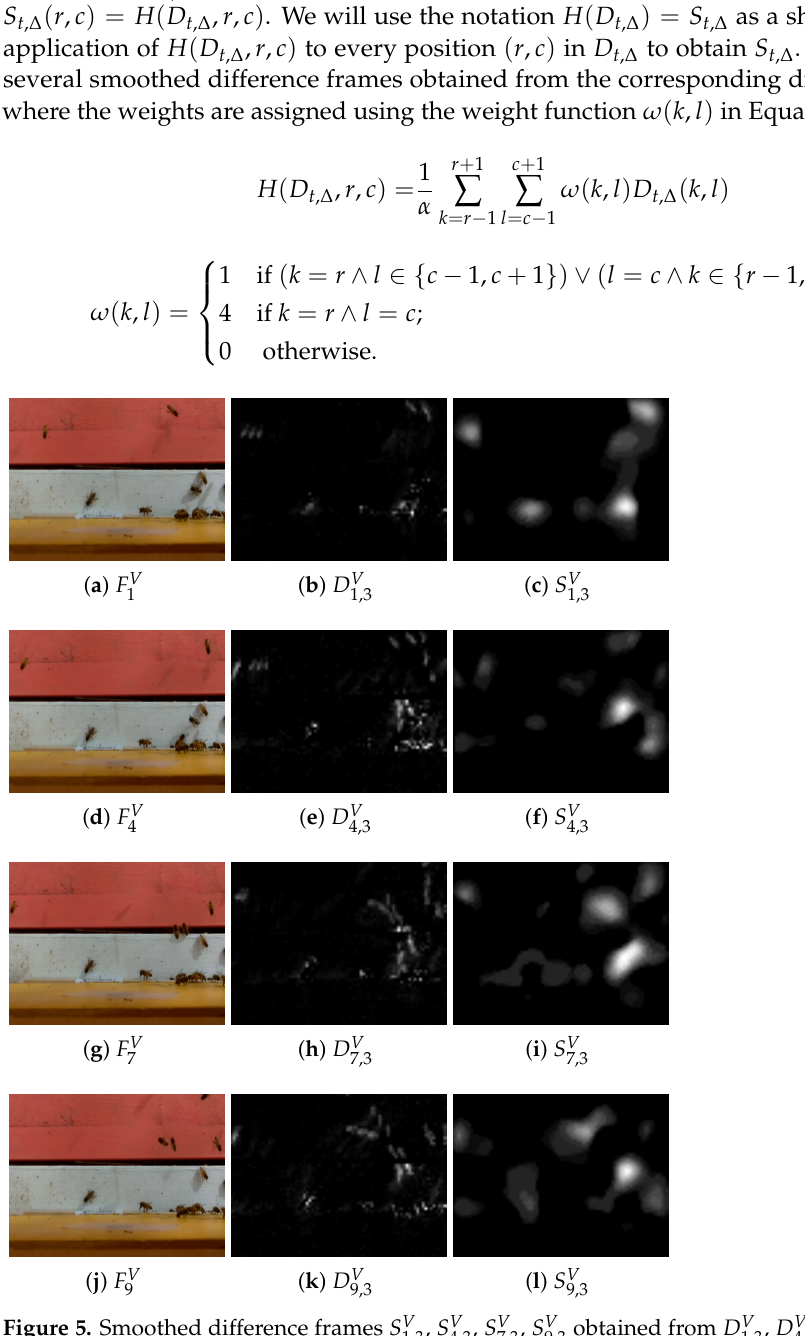
, S V , S V , S V obtained from D V 7,3 9,3 1,3 4,3 , F V , F V , F V of video V in Figure 2; ∆ = 3, α = 8 (see Equation (9)), and weight 7 9 1 4